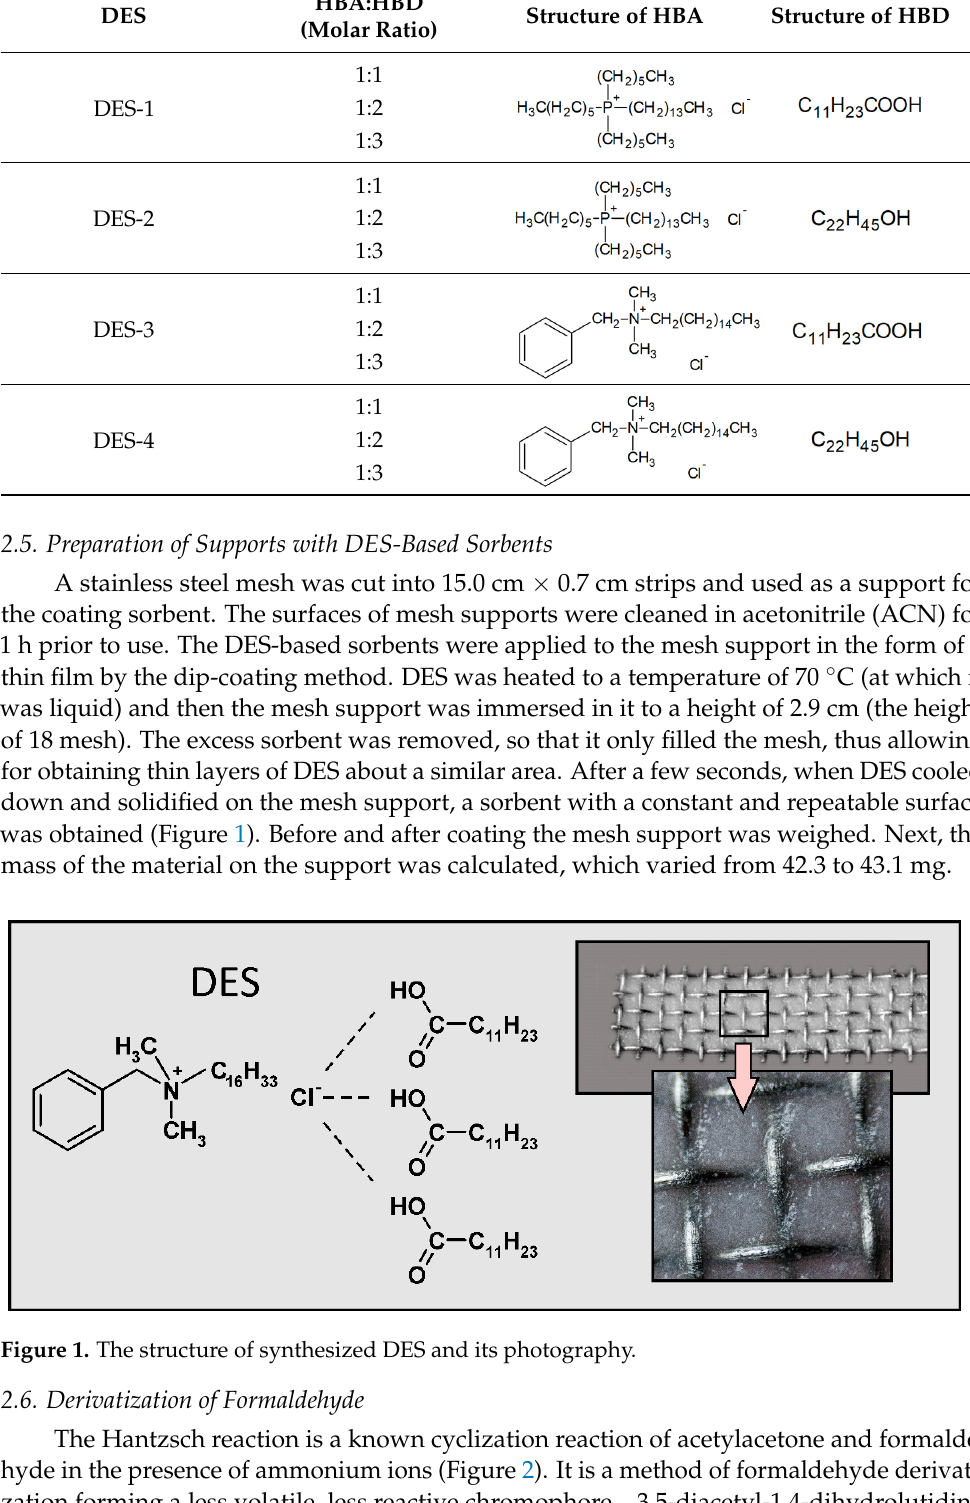
Table 1. Structures of DES-based coating sorbents composed of HBA and HBD in different molar ratios. DES